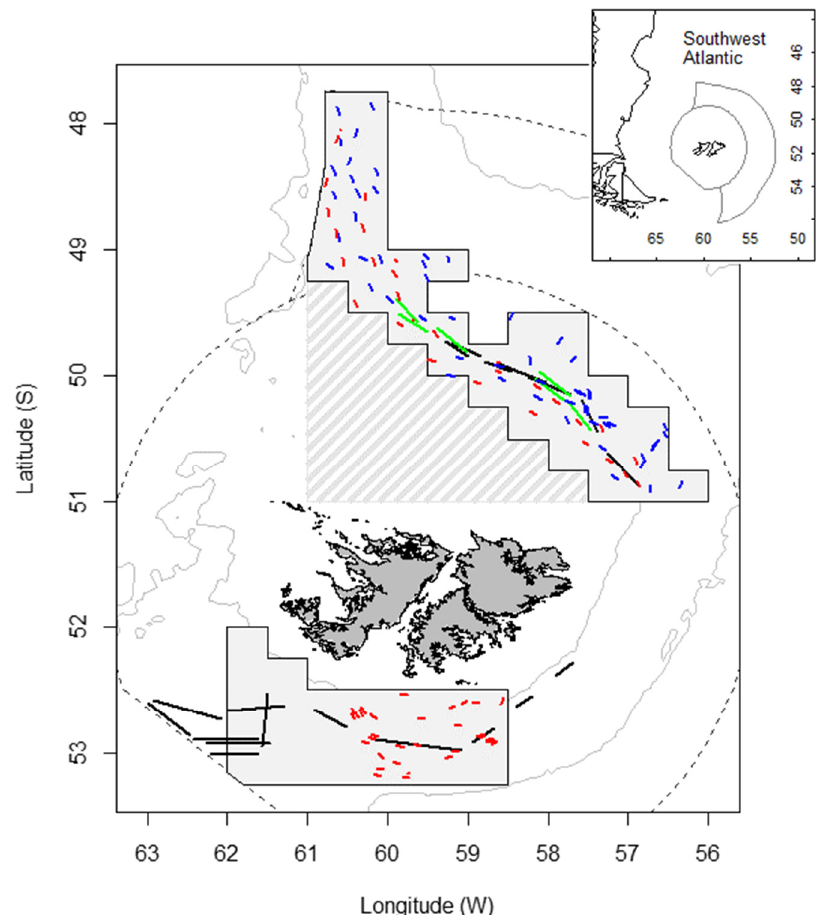
Figure 1. Distribution of survey trawl tracks in 2013 (red), 2018 (green—400 mm mesh only), 2019 (blue), and 2021 (black); corresponding to Table 1. Grey shaded areas: North and South Skate Boxes. Grey striated area: shelf skate spawning area. Boundary lines: Falkland Islands Conservation Zones.